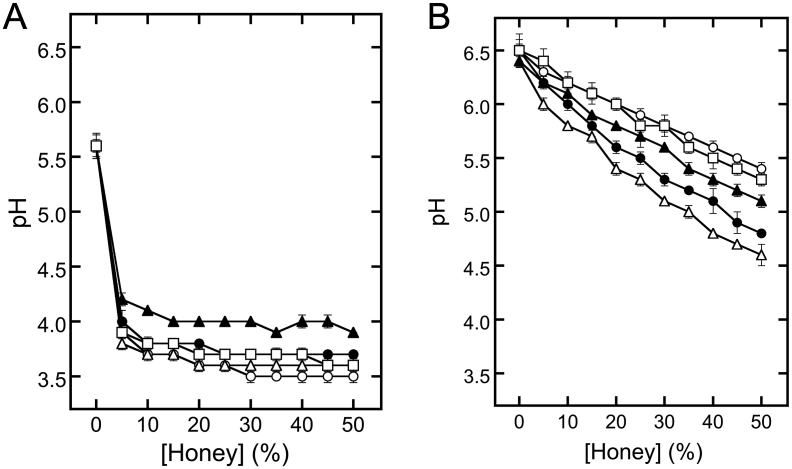
Changes in soymilk pH upon the addition of honey. Honey was mixed with distilled water (A) or soymilk (B) at various concentrations. The mixture was incubated and centrifuged. The pH of the supernatant was measured. Open circles, closed circles, open triangles, closed triangles, and open squares indicate acacia, coffee, buckwheat, bindweed, and blended kinds of honey, respectively.